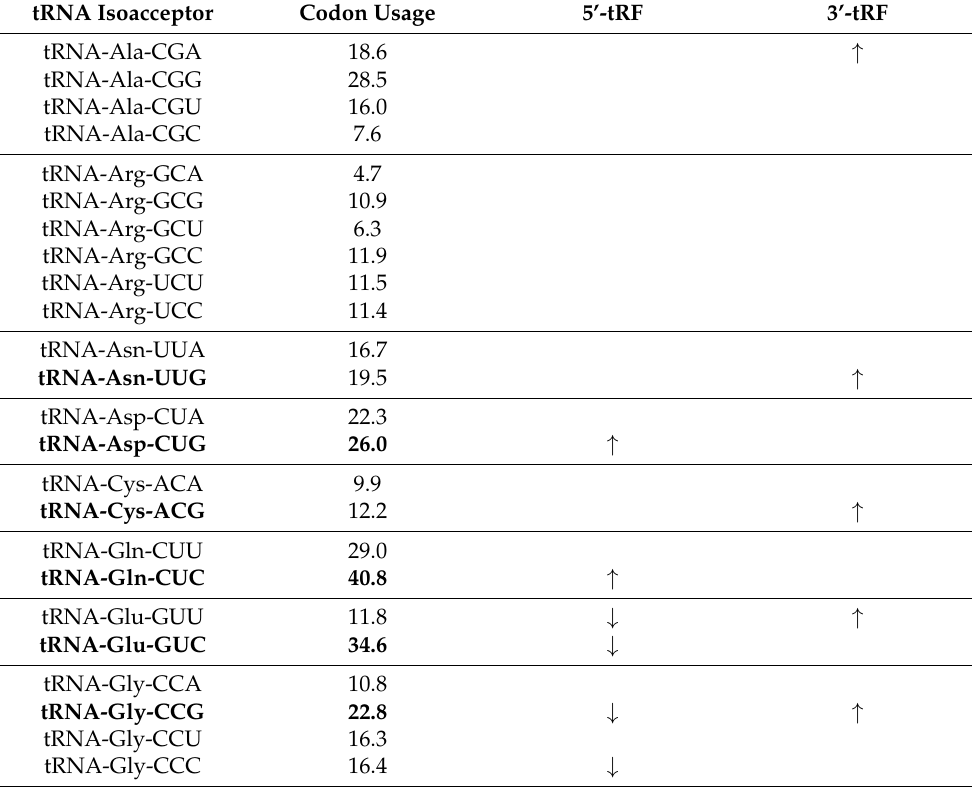
Table 2. tRFs which are deregulated in OA [122,123].